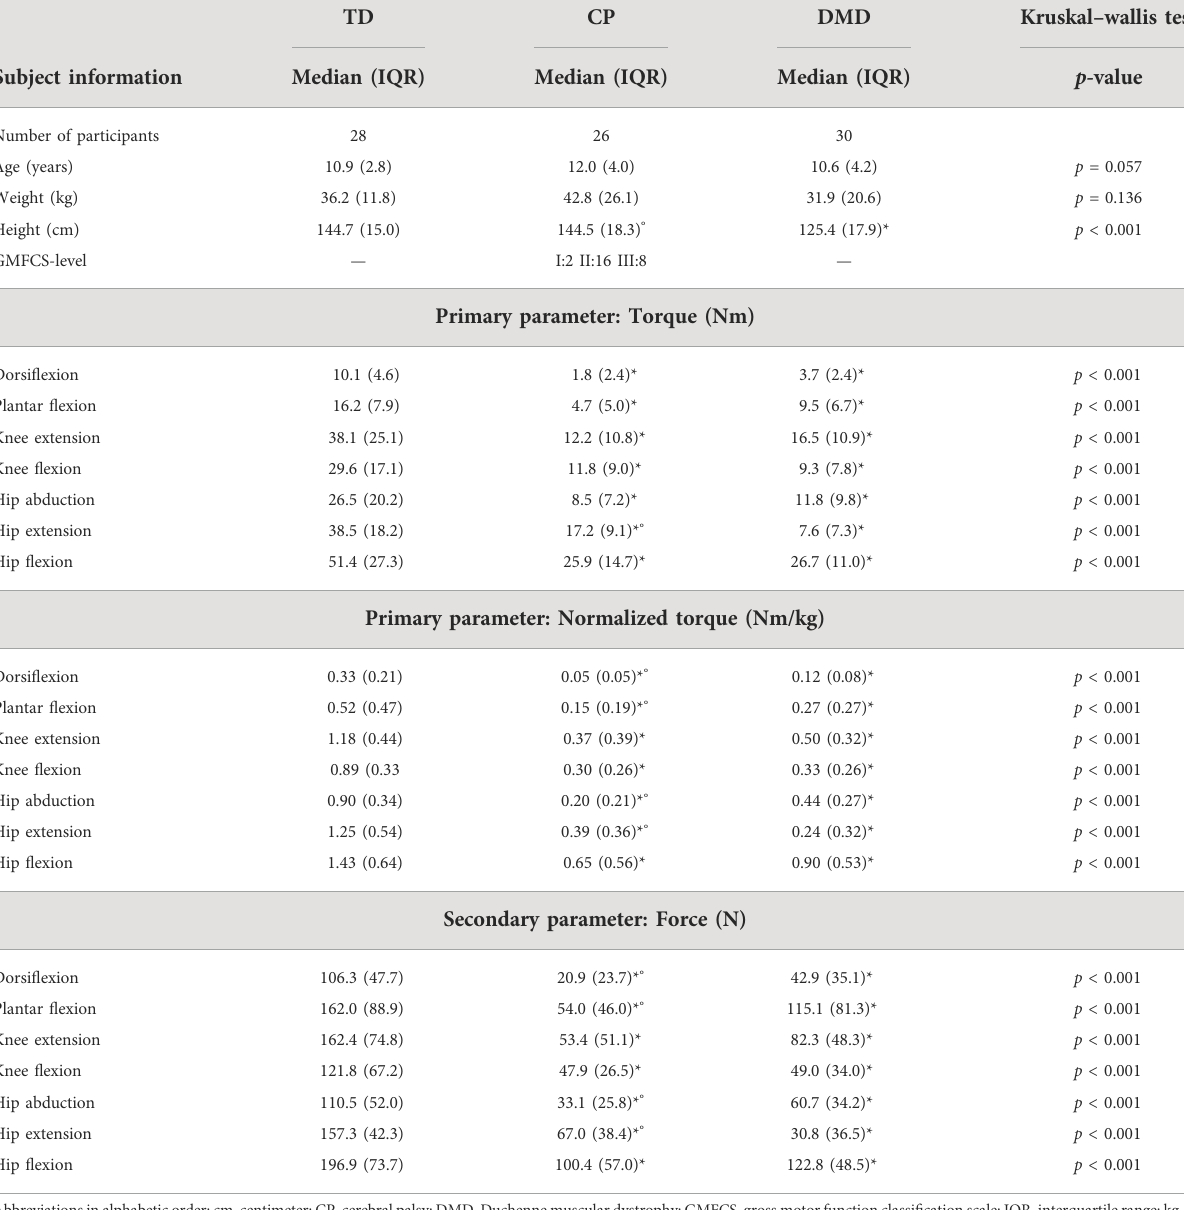
TABLE 4 Subject characteristics and median torque, normalized torque and force of the TD, CP, and DMD cohorts and statistical results of the comparison of the three cohorts, included in the validity study. TD CP DMD Kruskal – wallis